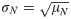
(a) Relationship between mean and standard deviation of customer-quantities time series for the soft drink category. Regarding plot points, for each day of week: circle, weekly totals: cross, on 1 store: red, within 1 locality: green, within city: blue. Black solid line shows σN=μN, and black dashed line shows σN = 0.10μN. (b) Mean of (a).